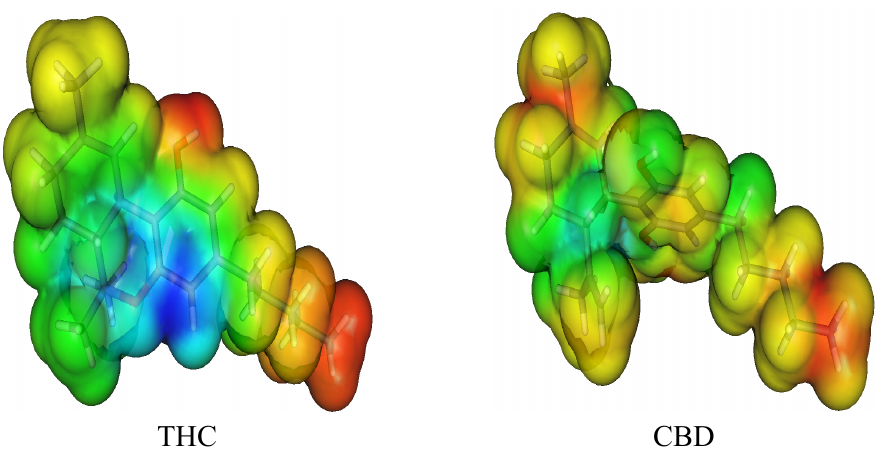
Figure 5. Molecular electrostatic potential (MEP) surface of cannabinoid derivatives.